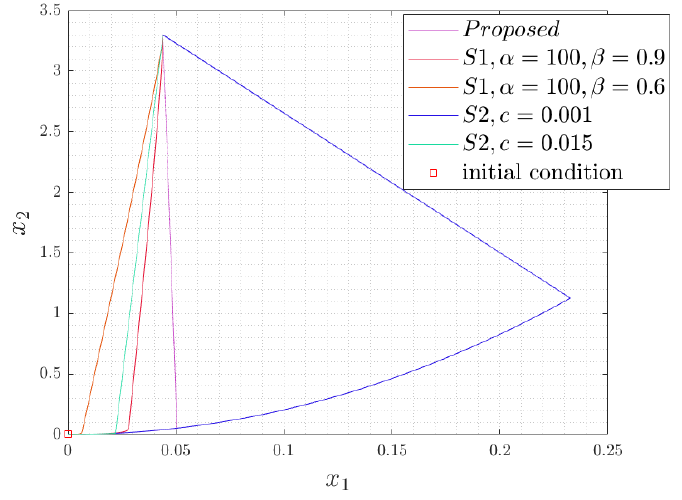
Figure 2. Phase portraits of the three sliding surfaces given in Section 2.